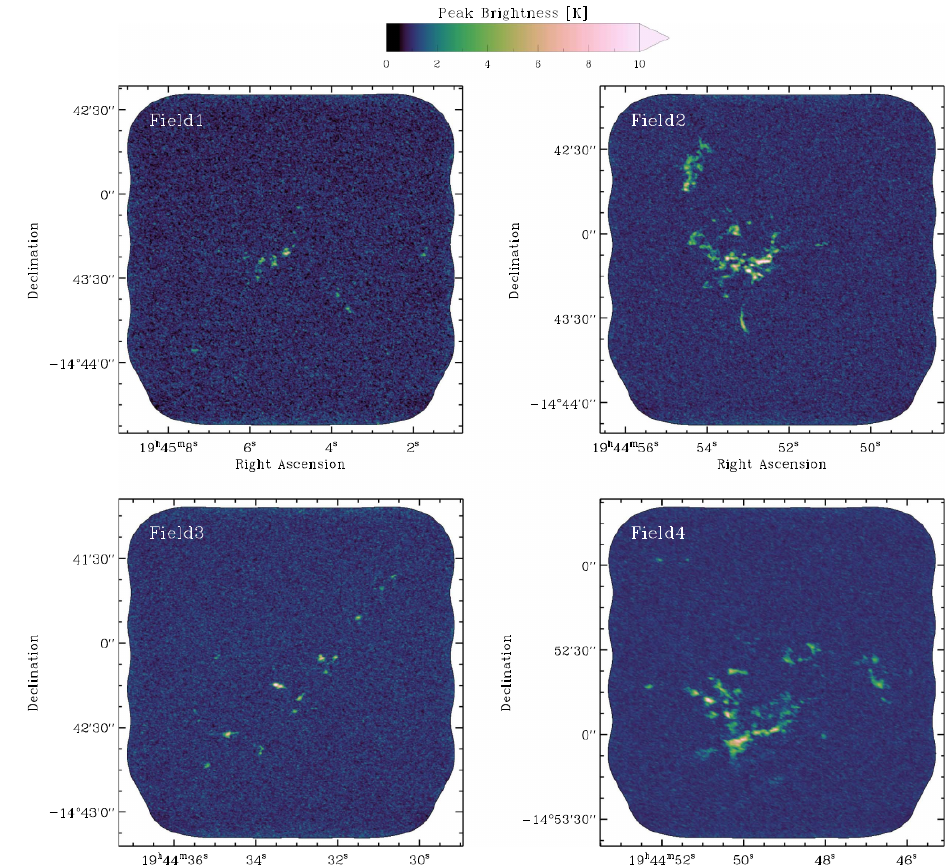
Figure 4. ALMA data with 2pc linear resolution (0. (cid:48)(cid:48) 9) of four selected regions with star-forming activity inside of NGC6822 taken from